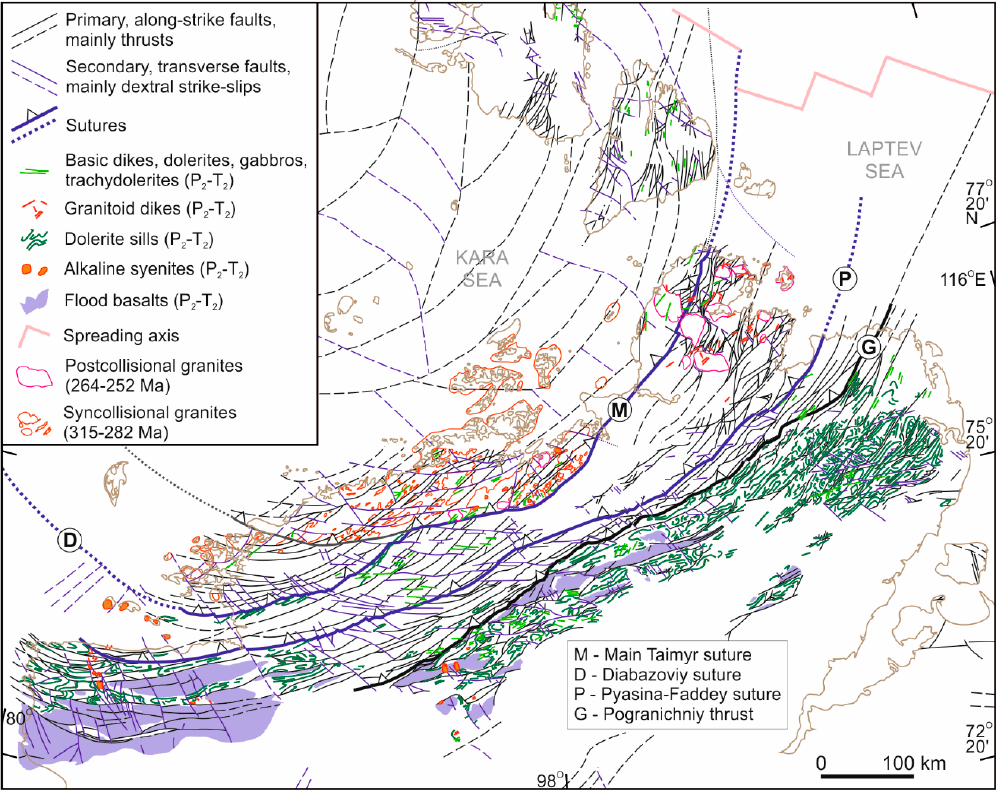
Figure 2. Schematic map of the Kara orogen based on State geological maps (scale 1:1,000,000) [80–83] showing the location patterns of faults and Permian postcollisional and Permian–Triassic Siberian LIP igneous rocks.